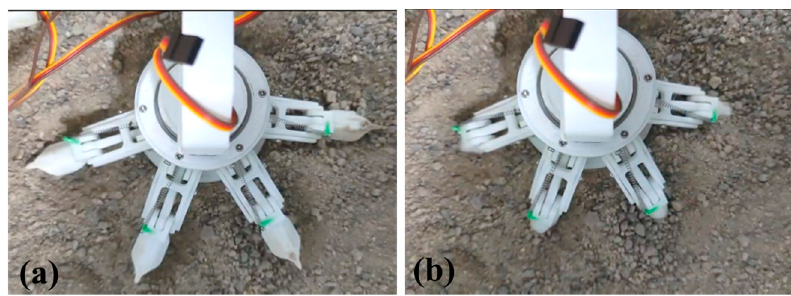
Figure 13. Grasping tests: ( a ) retrieving state and ( b ) grasping state.